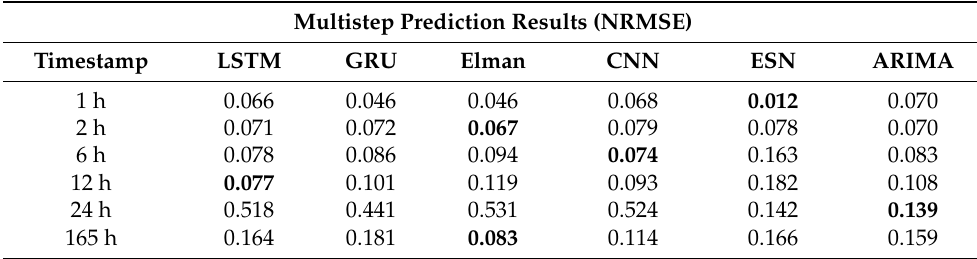
Table 2. Normalized root mean squared error (NRMSE) at short- and longer-term forecasting horizon. Multistep Prediction Results (NRMSE) Timestamp LSTM GRU Elman CNN ESN